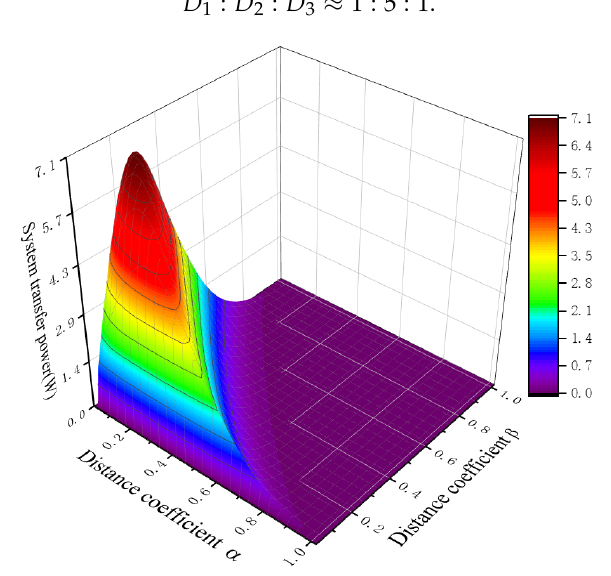
Figure 6. Relationship between transfer power and distance coefficient α , β of a two-intermediate coil MCR-WPT